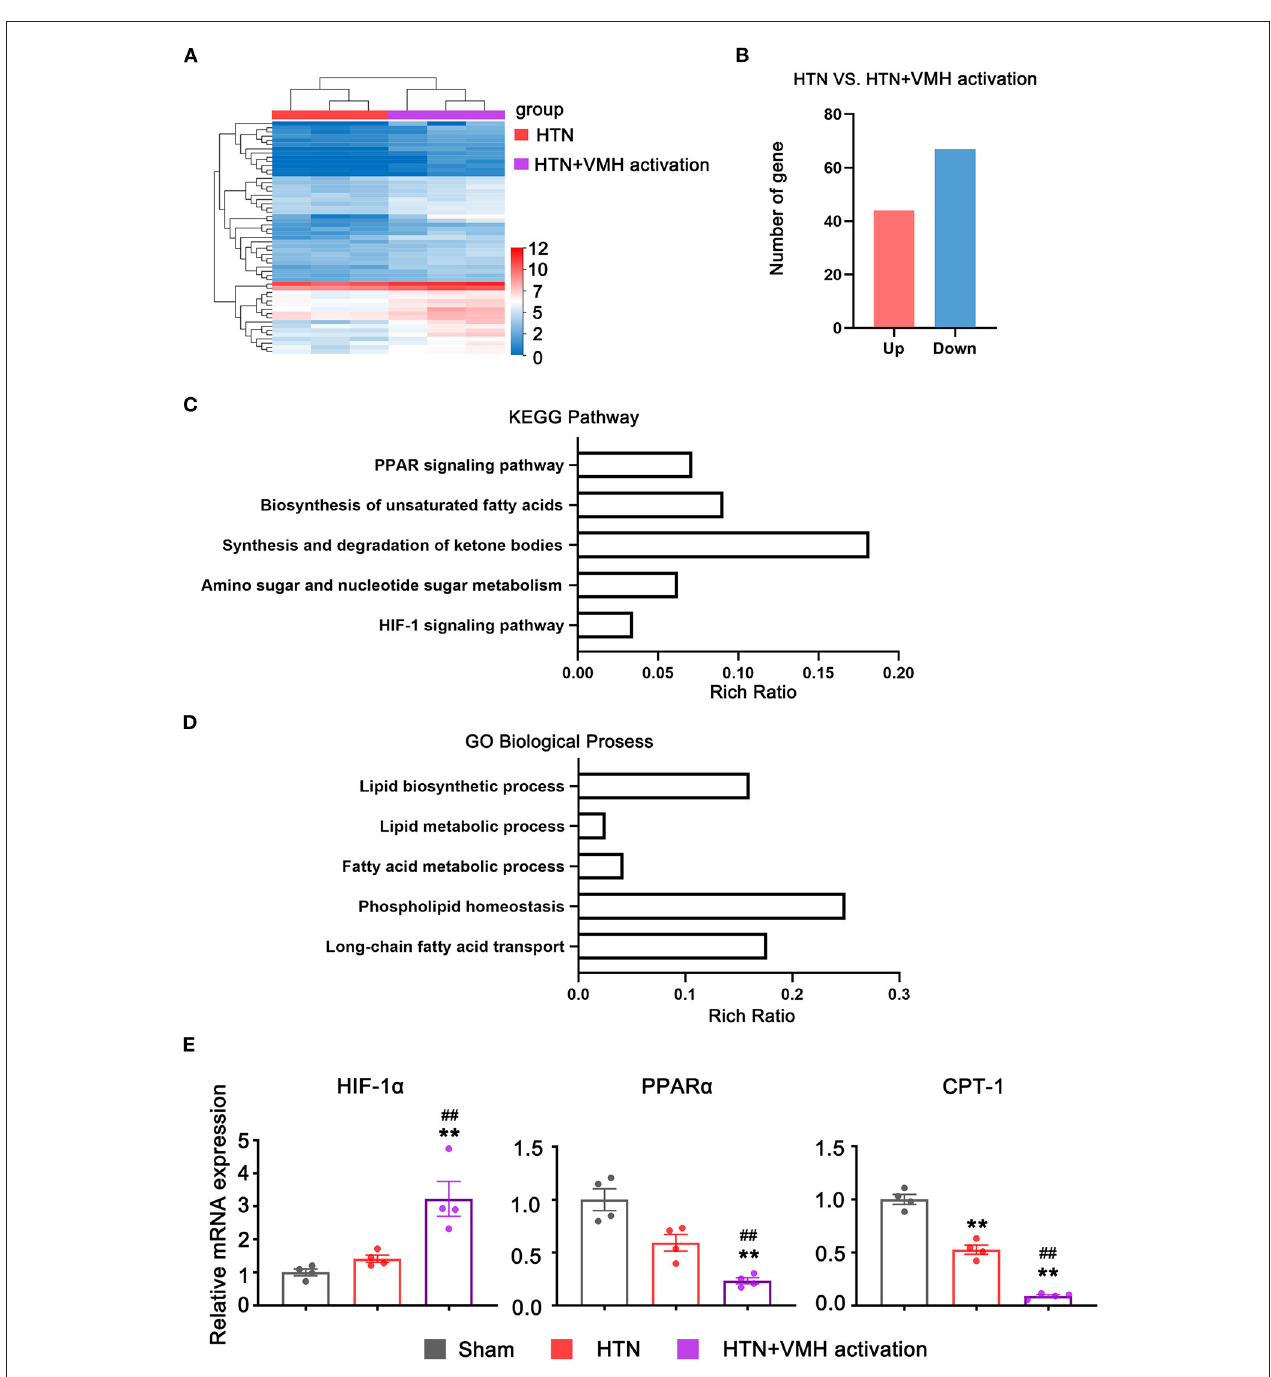
FIGURE 5 | The RNA-seq and qPCR analysis results. (A) Heatmap of expression genes between HTN and HTN + VMH activation group ( n = 3 per group); (B) Number of up-regulated and down-regulated genes between HTN and HTN + VMH activation group ( n = 3 per group); (C) KEGG pathway enrichment analysis between HTN and HTN + VMH activation group; (D) GO biological process analysis between HTN and HTN + VMH activation group; (E) The relative mRNA expression of HIF-1 α , PPAR α , and CPT-1 in sham group, HTN group, and HTN + VMH activation group. Values are presented as mean ± SEM ( n = 4 per group). ** p < 0.01; vs. sham group; ## p < 0.01 vs. HTN